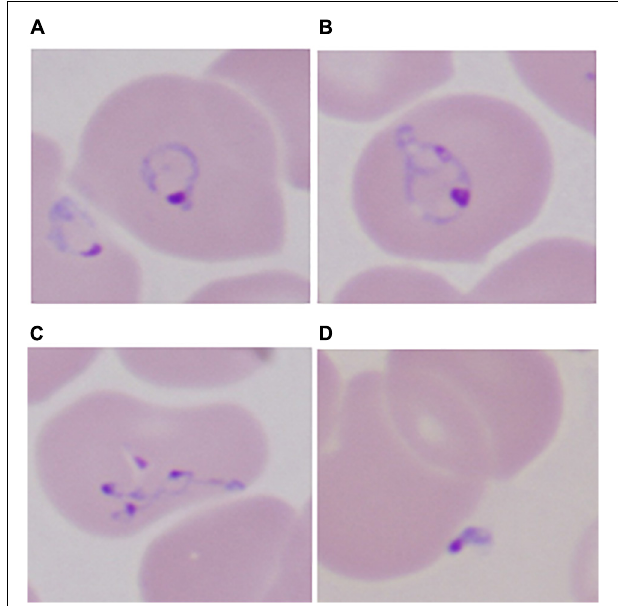
FIGURE 2 | Developmental stages of intraerythrocytic Babesia microti parasite by Giemsa-stained thin blood microscopy. (A) Ring form with cytoplasm stained blue; (B) mature trophozoite with two small nuclei; (C) a tetrad (Maltese cross); and (D) an extracellular form. 1000 × magnification. Adapted from Vannier and Krause (2012) (From The New England Journal of Medicine, Edouard Vannier, PhD., and Peter J. Krause, M. D., Human Babesiosis, 366, 2399. Copyright (2012) Massachusetts Medical Society. Reprinted with